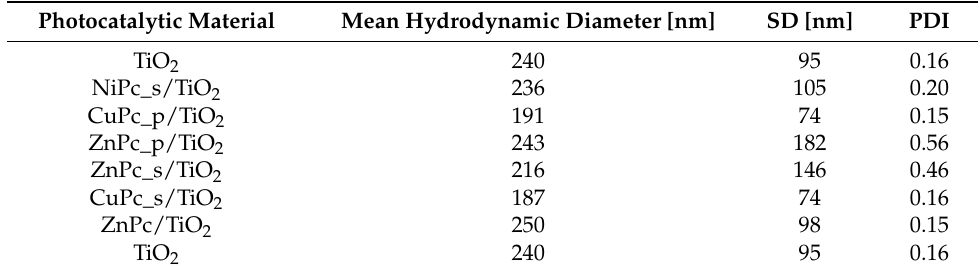
Table 2. Hydrodynamic diameter values of the particles obtained using